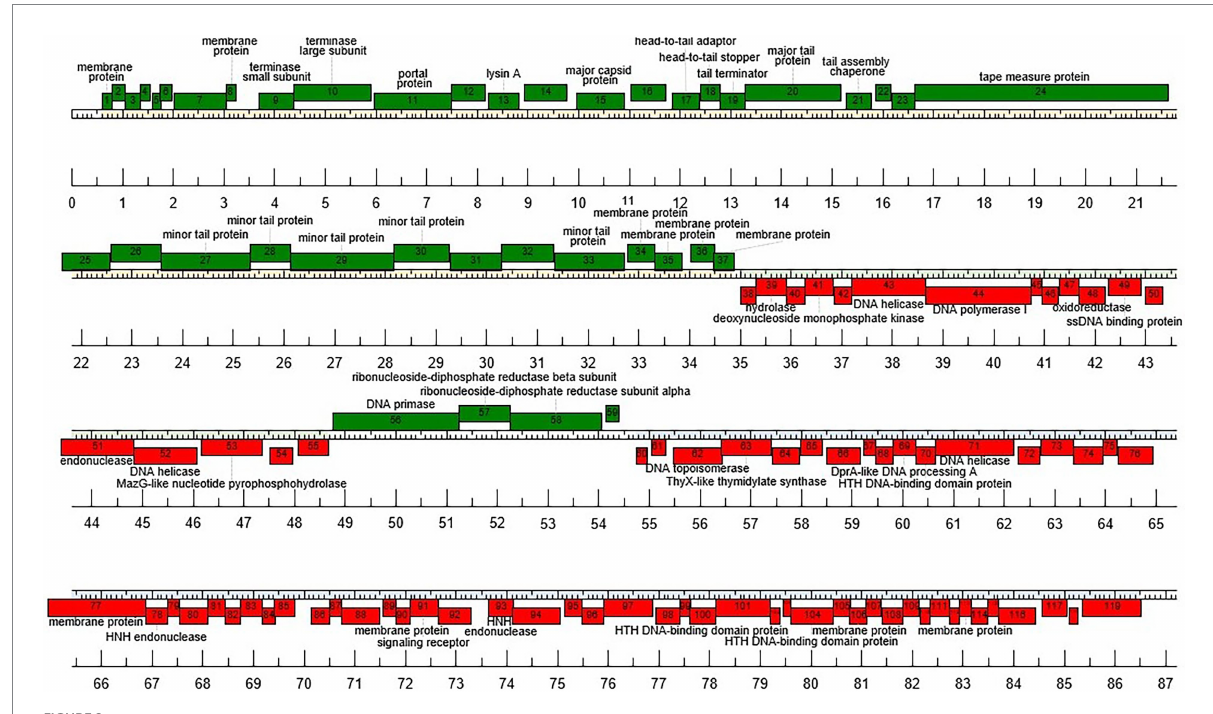
FIGURE 2 Genome organization of Brevundimonas phage vB_BsubS-Delta. Predicted genes are represented as boxes above or below the genome, denoting, respectively, rightwards- and